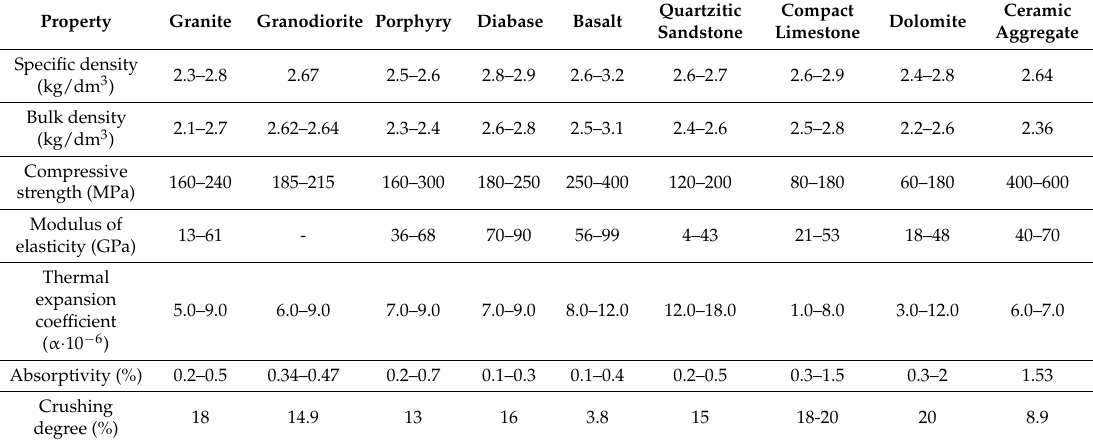
Table 1. Properties of ceramic aggregate in relation to aggregates used in concretes